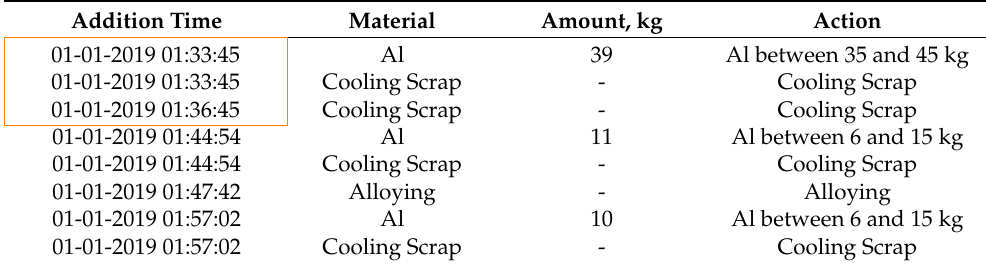
Table 6. Example of heat’s actions after discretisation. Addition Time